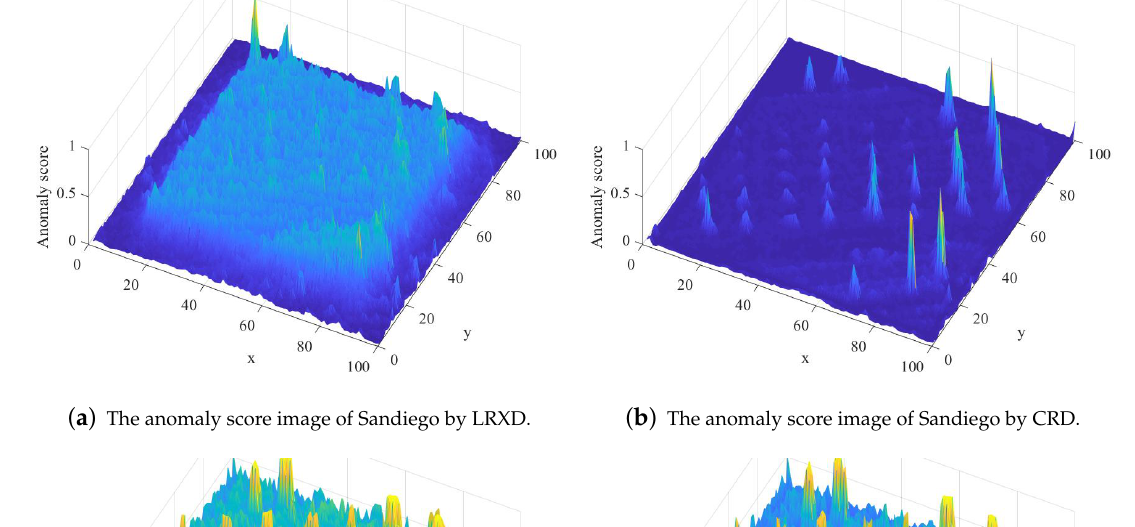
( a ) The anomaly score image of Sandiego by LRXD. ( b ) The anomaly score image of Sandiego by CRD.